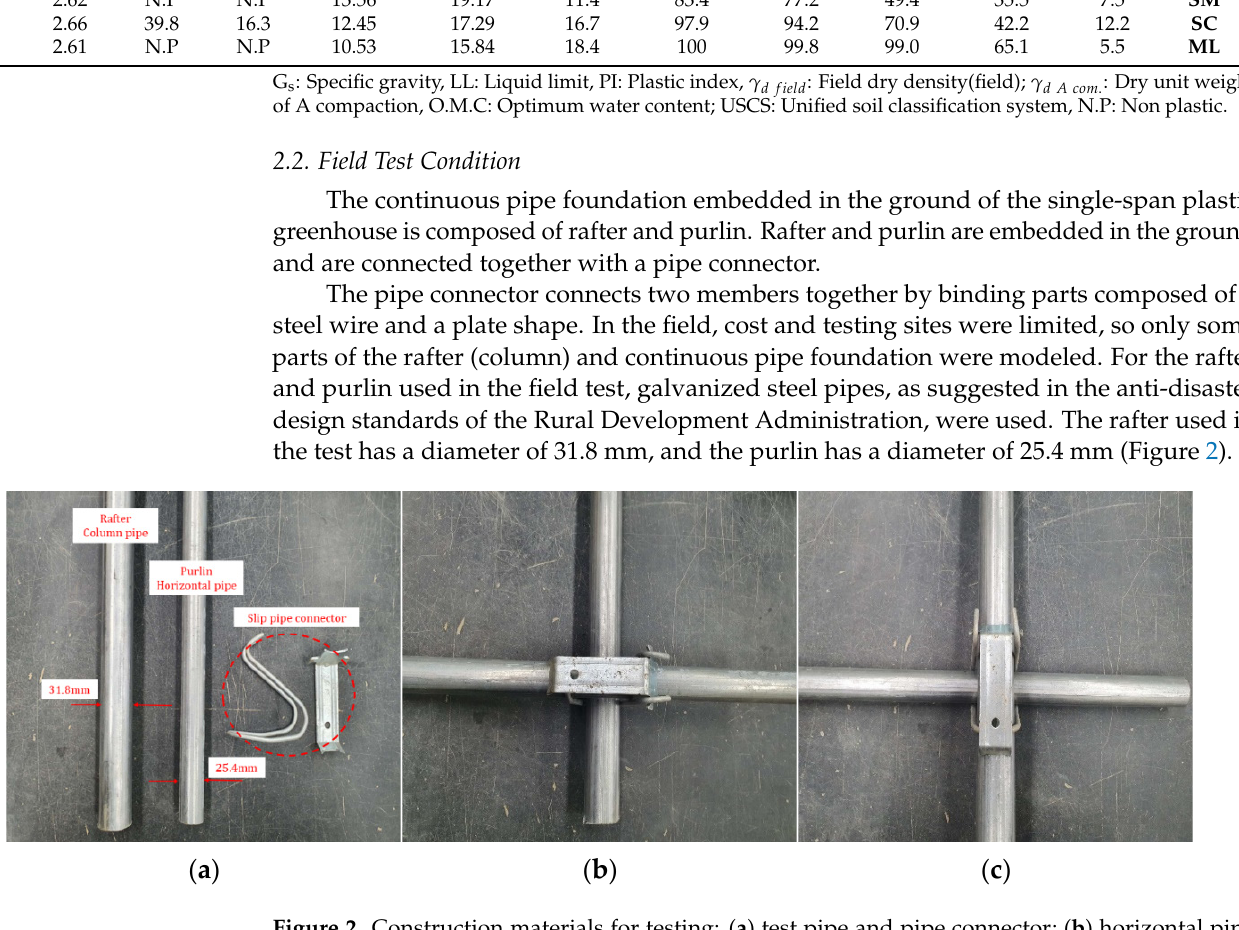
Figure 2. Construction materials for testing: ( a ) test pipe and pipe connector; ( b ) horizontal pipe connector; ( c ) vertical pipe